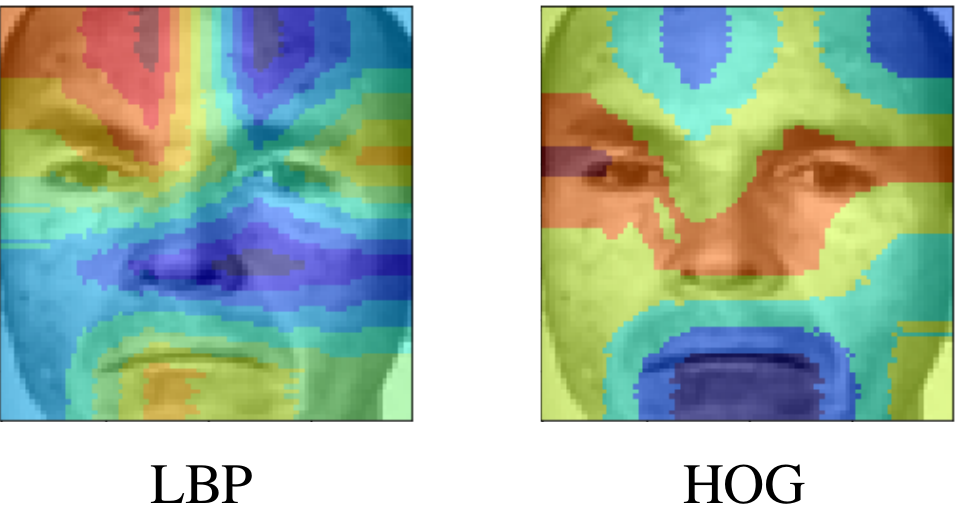
Figure 13. Most important zones of the faces for surprise.